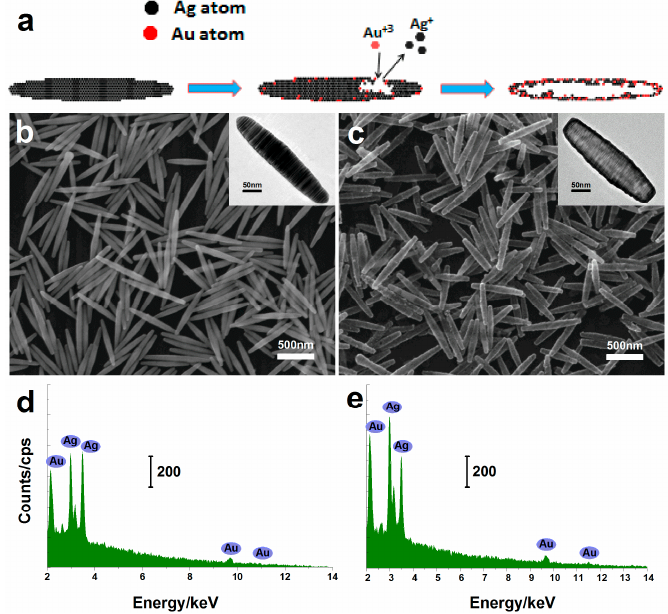
Figure 1. ( a ) Schematic illustration of the reaction process. ( b , c ) SEM and TEM (inset) of the Ag